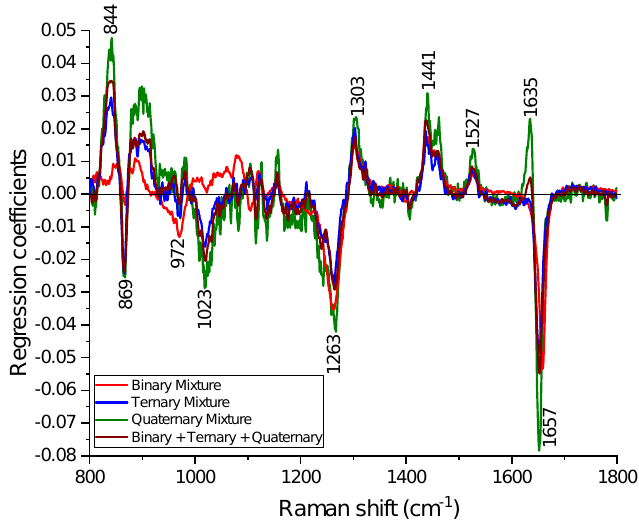
Figure 6. Regression coefficients of PLS models developed from binary, ternary, quaternary and combined (binary + ternary + quaternary) dataset. The curves are scaled for better visualization.